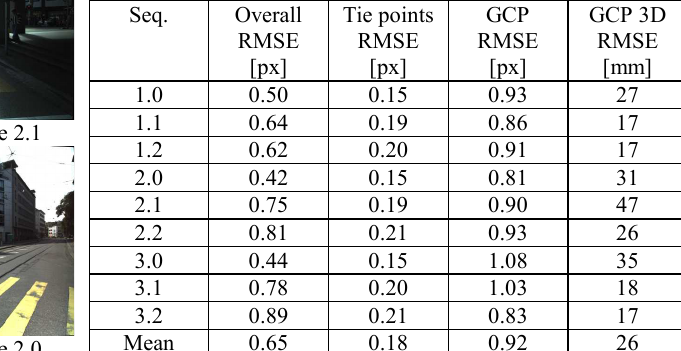
Table 5. Reprojection errors and 3D residuals of ground control points (GCP) from bundle adjustment